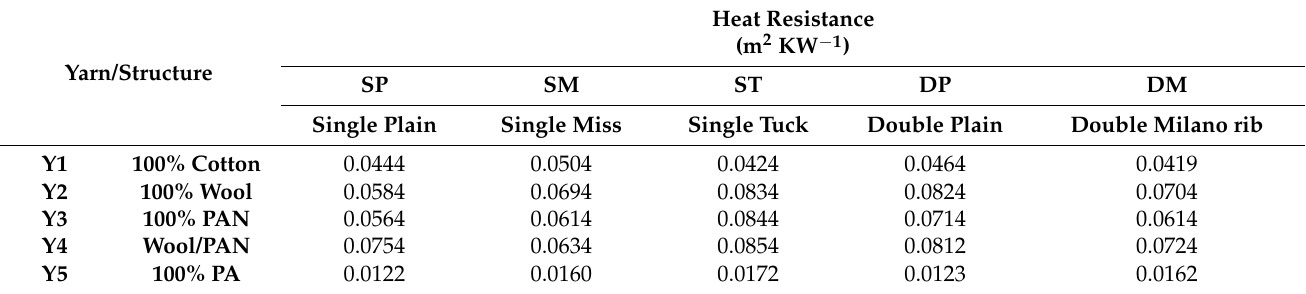
Table 5. Heat resistance of knitted